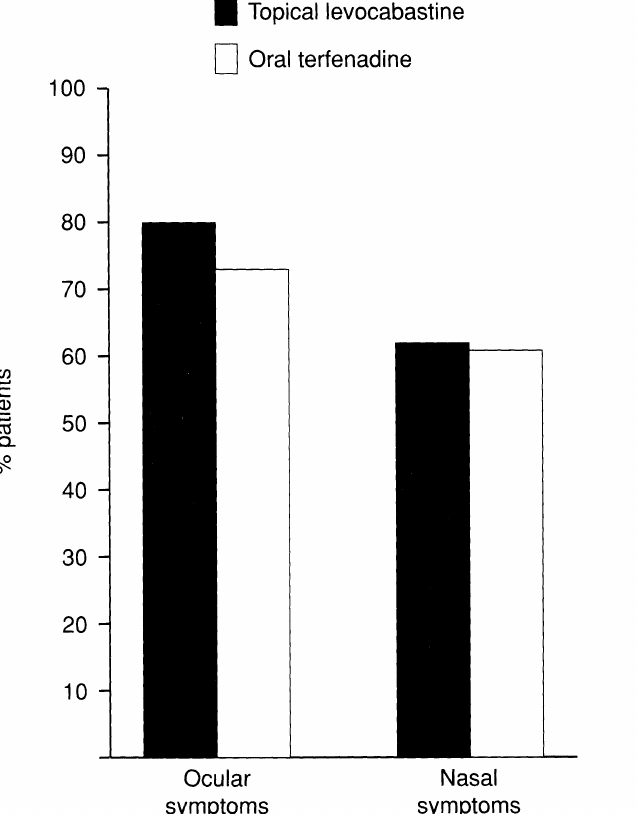
FIG. 1. Percentages of patients reporting excellent or good global therapeutic efficacy for ocular and nasal symptoms after 8 weeks of treatment with topical levocabastine or oral terfena- dine. 33 Reproduced with the kind permission of Blackwell Scien- tific Publishers, London,